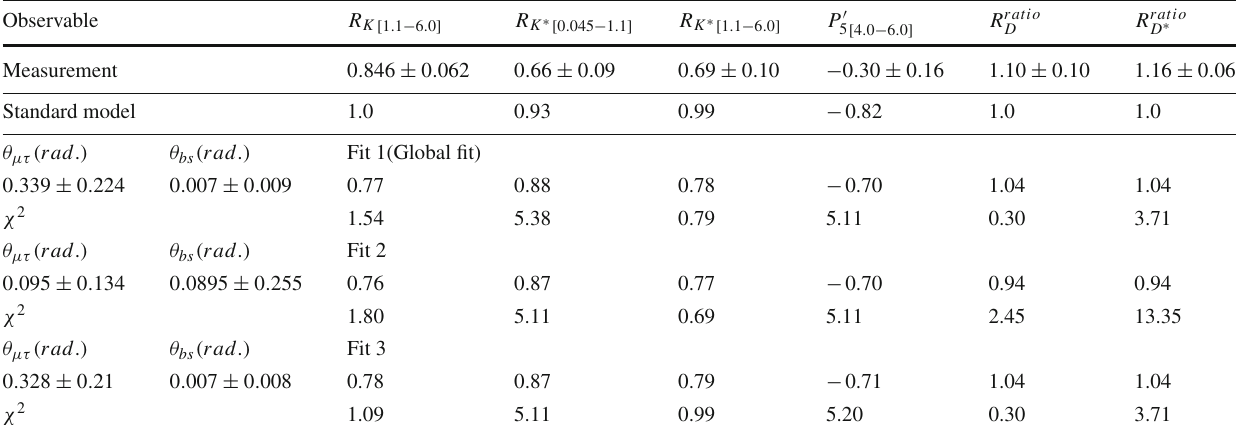
Table 2 Best fit values of the mixing angles in U 1 leptoquark model. For Fit 1, dof=122, χ 2 / dof = 1 . 00